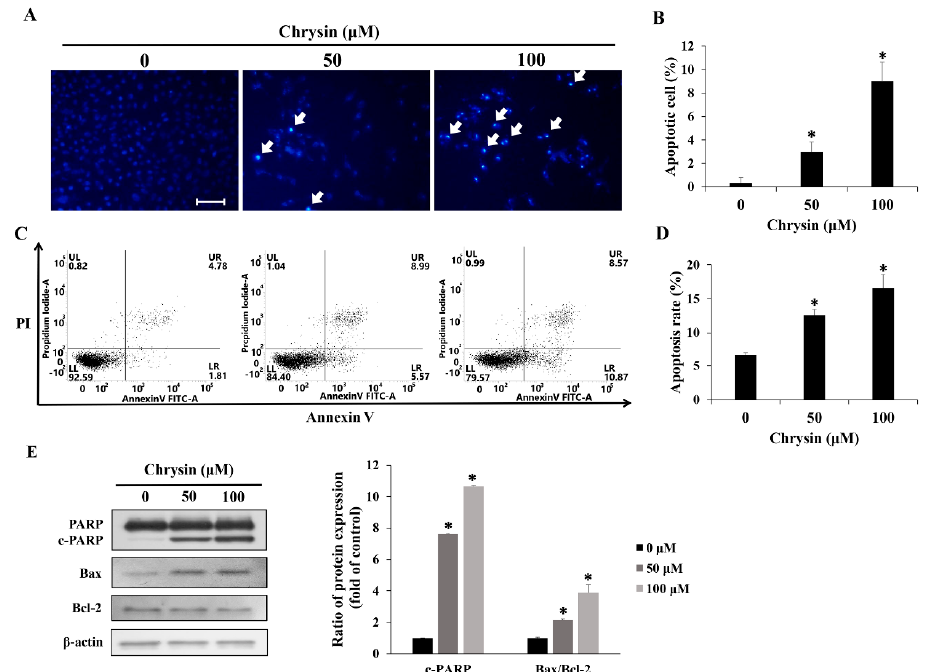
Figure 2. Chrysin induces apoptosis in MC-3 oral cancer cells. ( A ) Fluorescence microscopy image of cell morphology (scale bar = 10 µm) after chrysin treatment. The arrows indicate chromatin condensation in MC-3 cells. ( B ) The bar graph representing the average number of 4 ′ ,6-diamidino-2-phenylindole-positive cells as a percentage of all cells. ( C ) Cells stained with annexin V-propidium iodide and analyzed using flow cytometry. ( D ) Bar graph representing the percentage of cells in apoptosis among all cells. ( E ) The levels of the apoptosis-related proteins poly (ADP-ribose) polymerase, Bax, and B-cell lymphoma-2 (Bcl-2). Quantification was performed using Image J. The results are presented as the means and standard deviation of three independent samples. The statistical differences were determined by the Dunnett’s t -test: * p < 0.05, compared with the